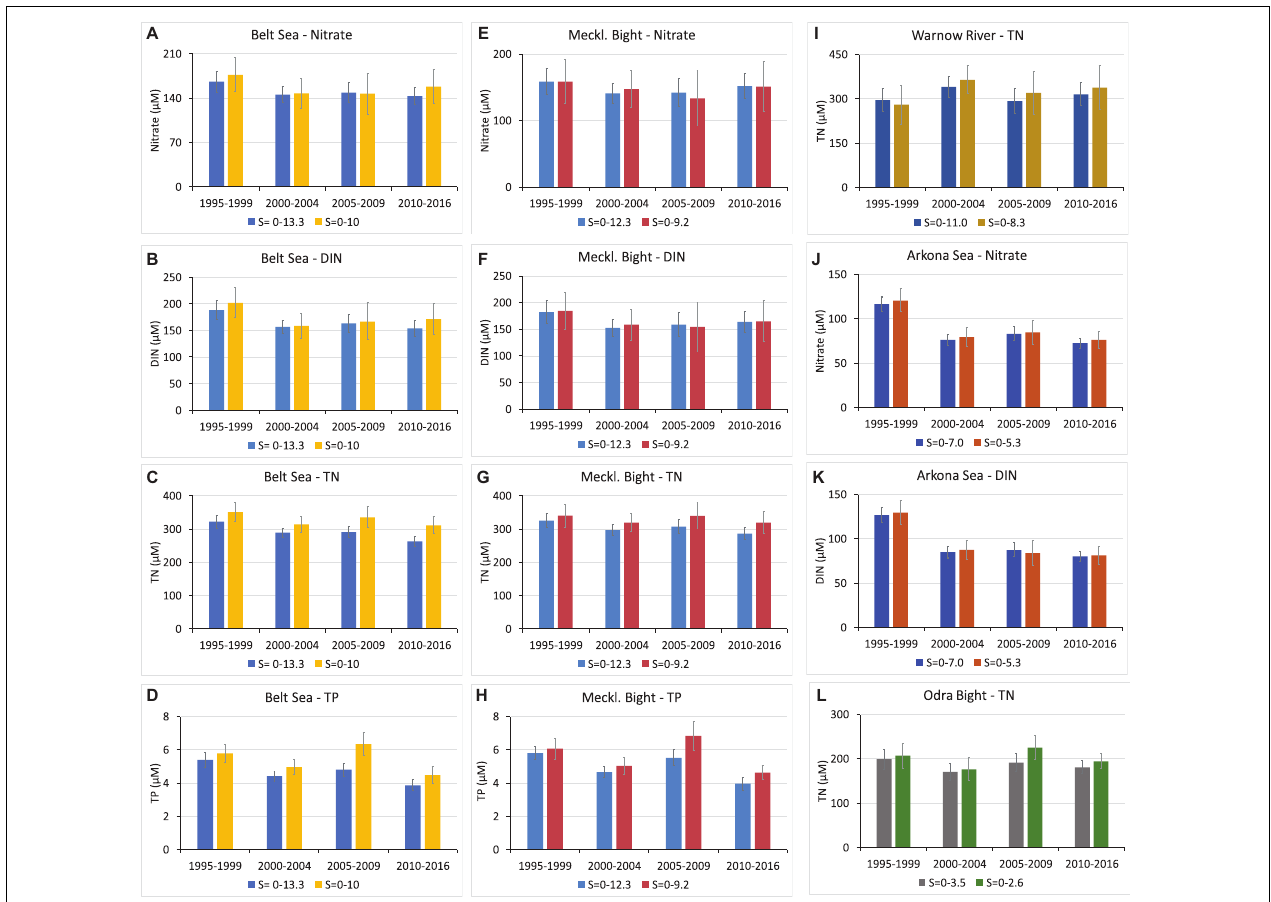
FIGURE 5 | Comparison of the freshwater end-members of Figure 4 (left bars) for the Belt Sea: nitrate (A) , DIN (B) , TN (C) , and TP (D) , for the Mecklenburg Bight: nitrate (E) , DIN (F) , TN (G) , and TP (H) , for Warnow River TN (I) , for Arkona Sea nitrate (J) , and DIN (K) , and for Odra Bight TN (L) with the results for the restricted salinity ranges (right bars, significant, > 99%) as anindicator of changes of the respective parameter during transport to the open sea (see Table 2 ); the 95% confidence intervals are given as error